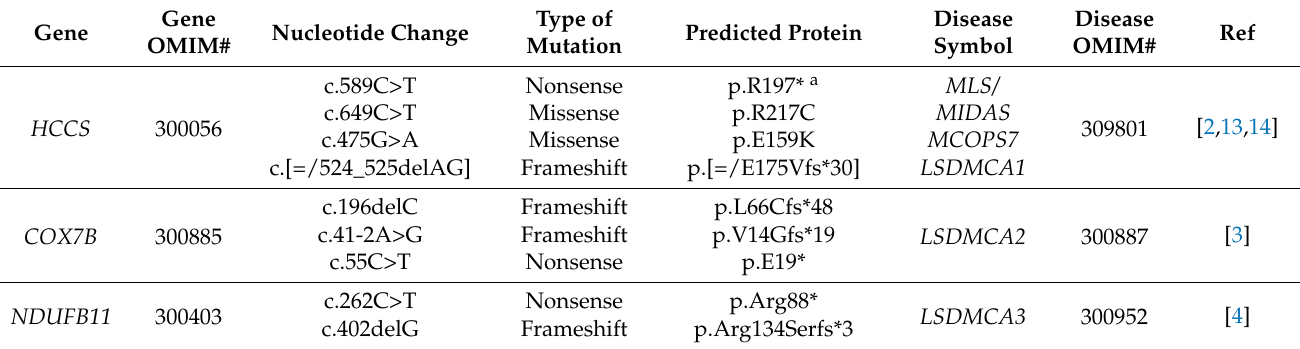
Table 1. Summary of point mutations identified to date in